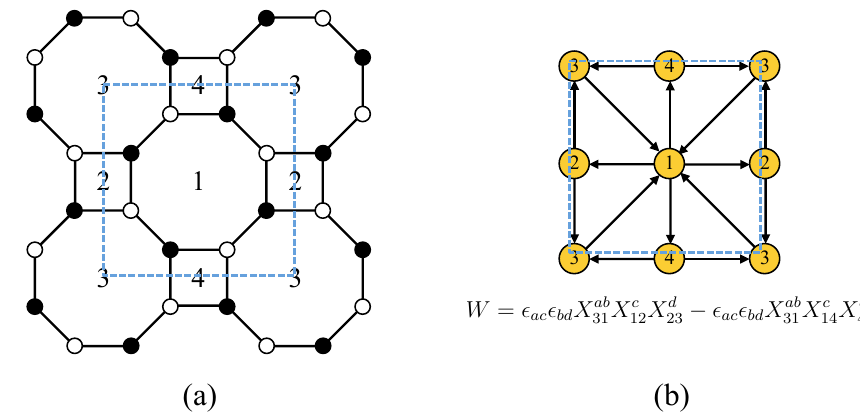
Figure 1. a) Brane tiling and b) dual periodic quiver for phase 2 of F 0 . The unit cell is indicated with dashed blue lines. We also show the superpotential, making the SU(2) of this theory